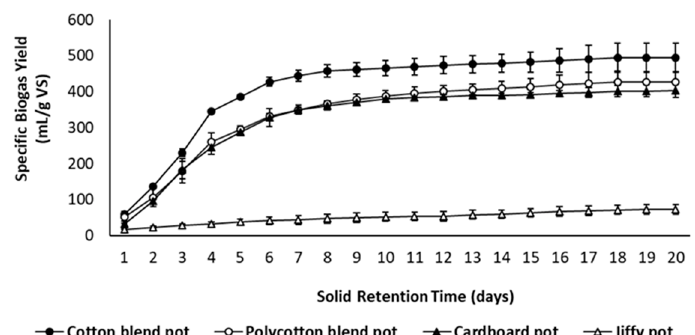
Figure 13. Specific biogas yield of seedling pots.